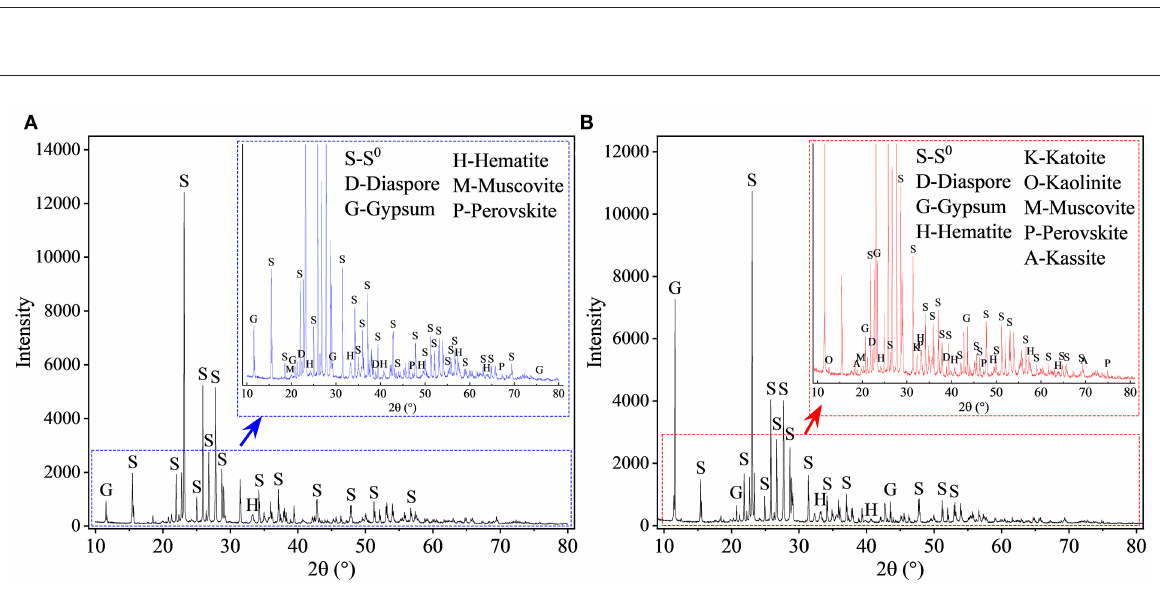
FIGURE11 XRD patterns of solid residues after leaching of metals from RM. Leaching was conducted for 27 days in a 5-L STR with the S 0 /RM mass ratio of 2:1. Residues from the following assays were analyzed: (A) S 0 + RM + Sb. thermosulfidooxidans + 1L air/min; (B) abiotic control (S 0 + RM + 1L air/min). The zoom image represents the enlarged area delineated by the blue or red